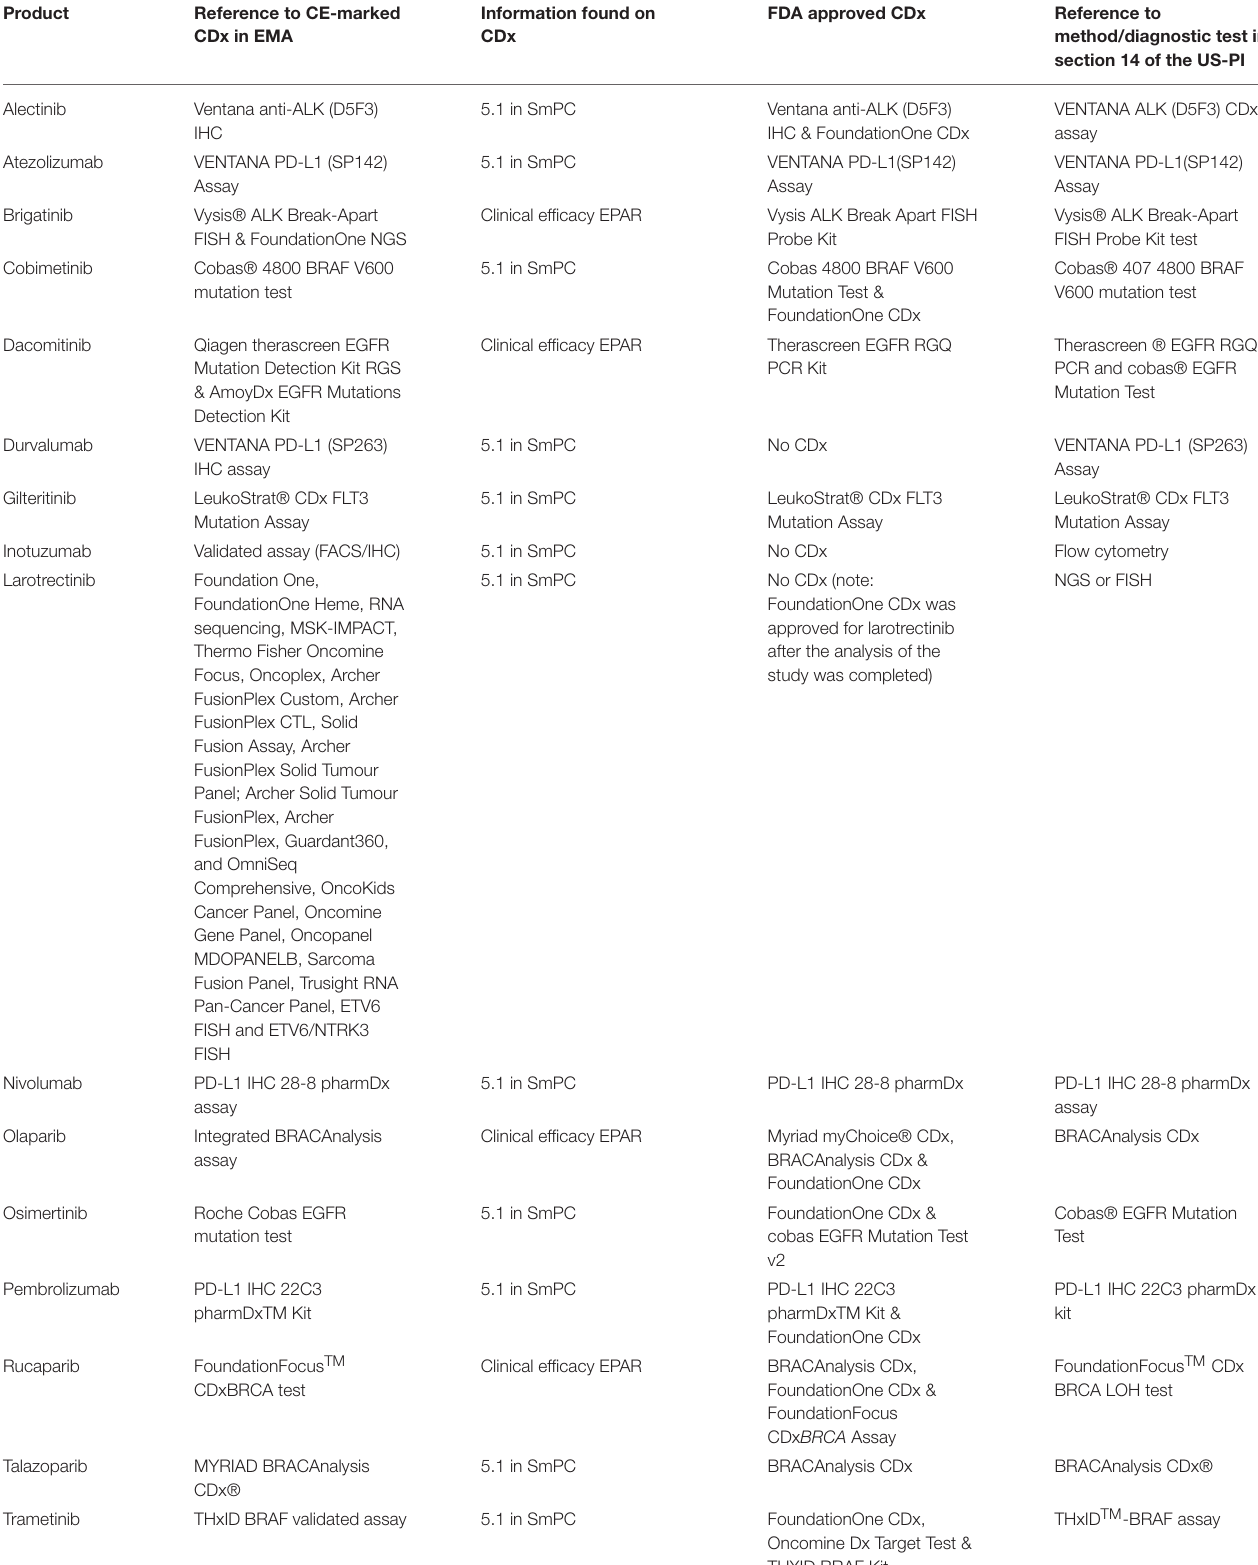
TABLE 5 | Comparison of medicinal products and associated companion diagnostic.